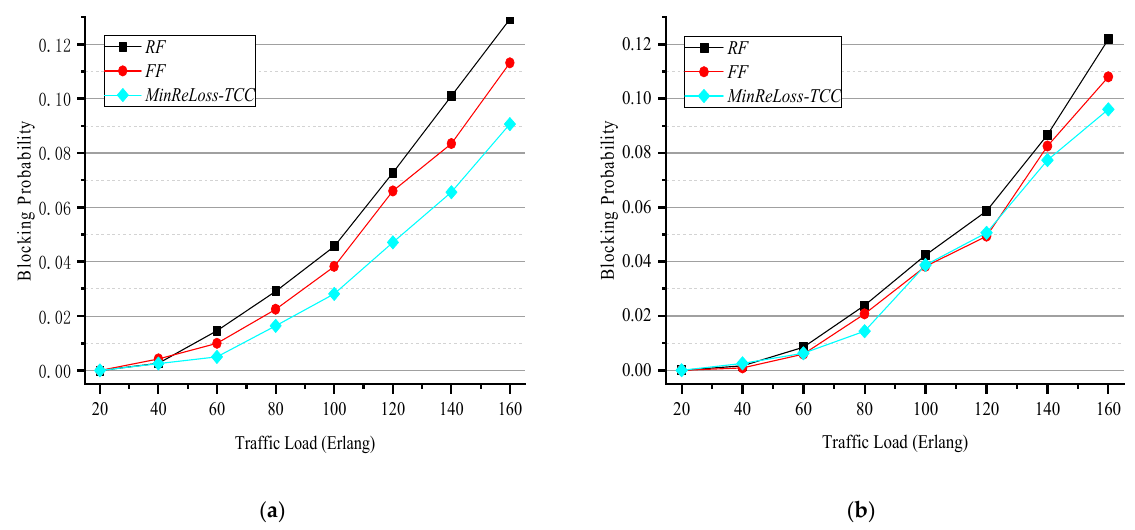
Figure 7. ( a ) Blocking probability vs. traffic load when the requirements of timeslots are diverse; ( b ) Blocking probability vs. traffic load when the requirements of timeslots are constant.